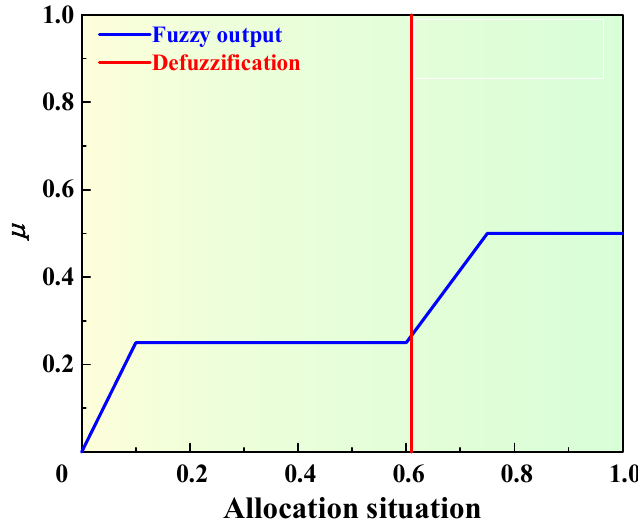
Figure 9. Defuzzification schematic.